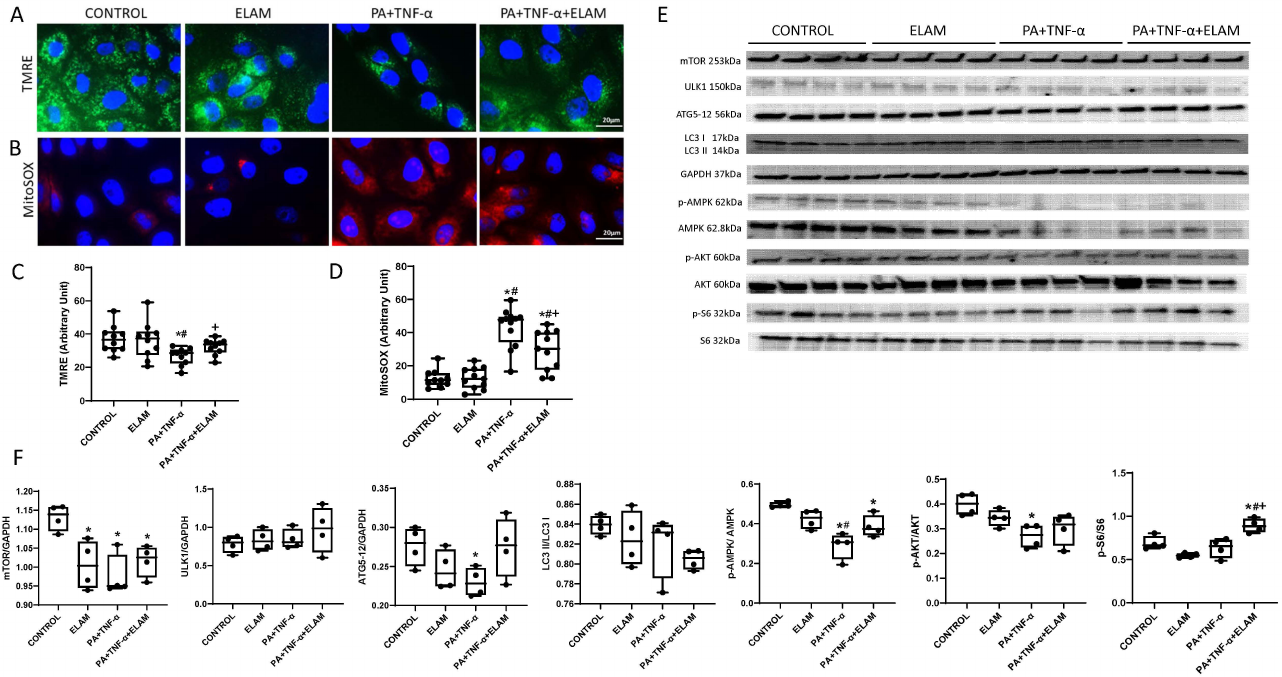
Figure 6. ELAM improves injured-PK1 cells mitochondrial function and autophagy proteins. ( A , B ) representative immunofluorescence staining ( × 40) for the mitochondrial membrane potential marker tetramethylrhodamine ethylester (TMRE; green) and the mitochondrial superoxide indicator (MitoSOX; red). ( C , D ) mitochondrial membrane potential decreased in PA+TNF- α -treated cells com- pared with control but increased after ELAM. Mito-SOX showed an opposite pattern in mitochondrial oxidative stress. ( E , F ) Protein expression of autophagy mediators in PA+TNF- α -treated PK1 cells with or without ELAM. * p < 0.05 vs. CONTROL, # p < 0.05 vs. ELAM, + p < 0.05 vs. PA+TNF- α . Scale bar = 20 µ